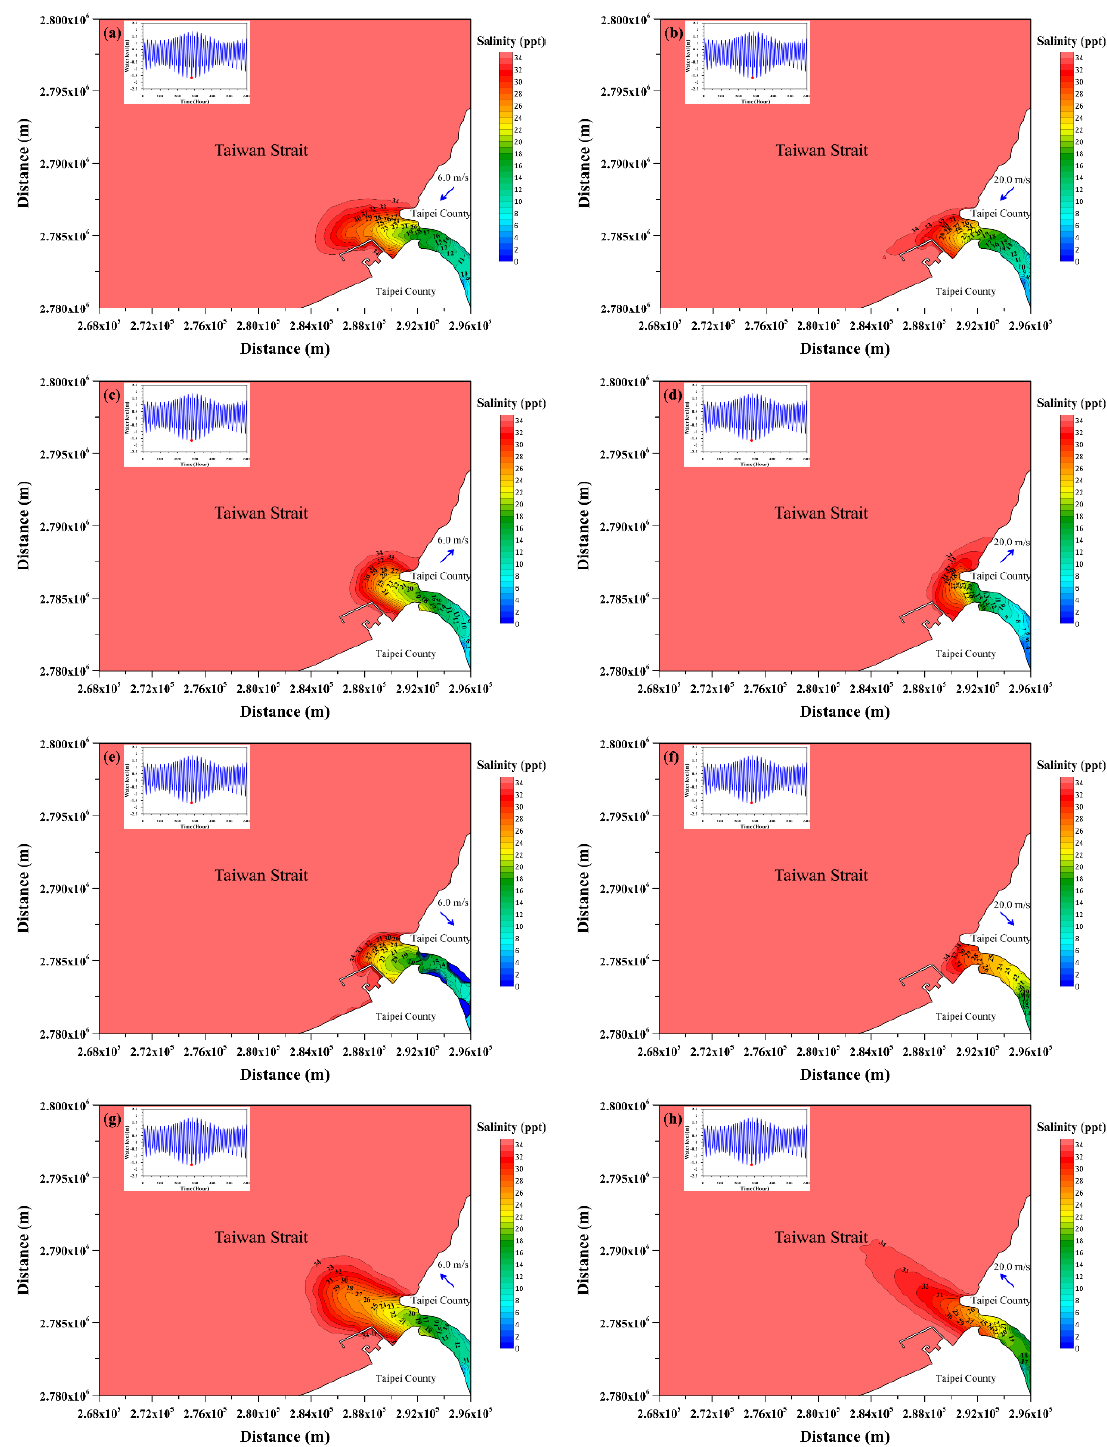
Figure 10. Surface salinity distributions under mean flow conditions for different wind speeds and directions: ( a ) 6 m/s northeast wind, ( b ) 20 m/s northeast wind, ( c ) 6 m/s southwest wind, ( d ) 20 m/s southwest wind, ( e ) 6 m/s northwest wind, ( f ) 20 northwest wind, ( g ) 6 m/s southeast wind, and ( h ) 20 m/s southeast wind.